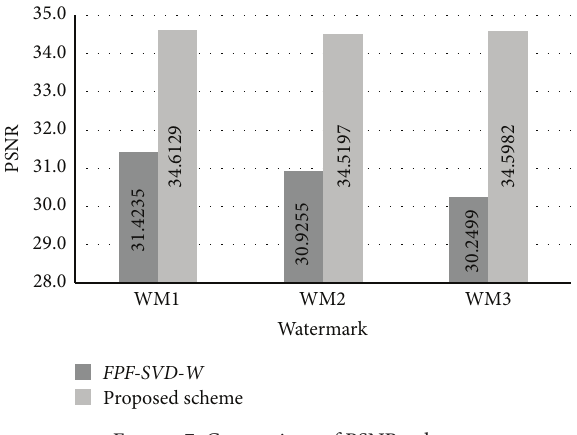
Figure 7: Comparison of PSNR